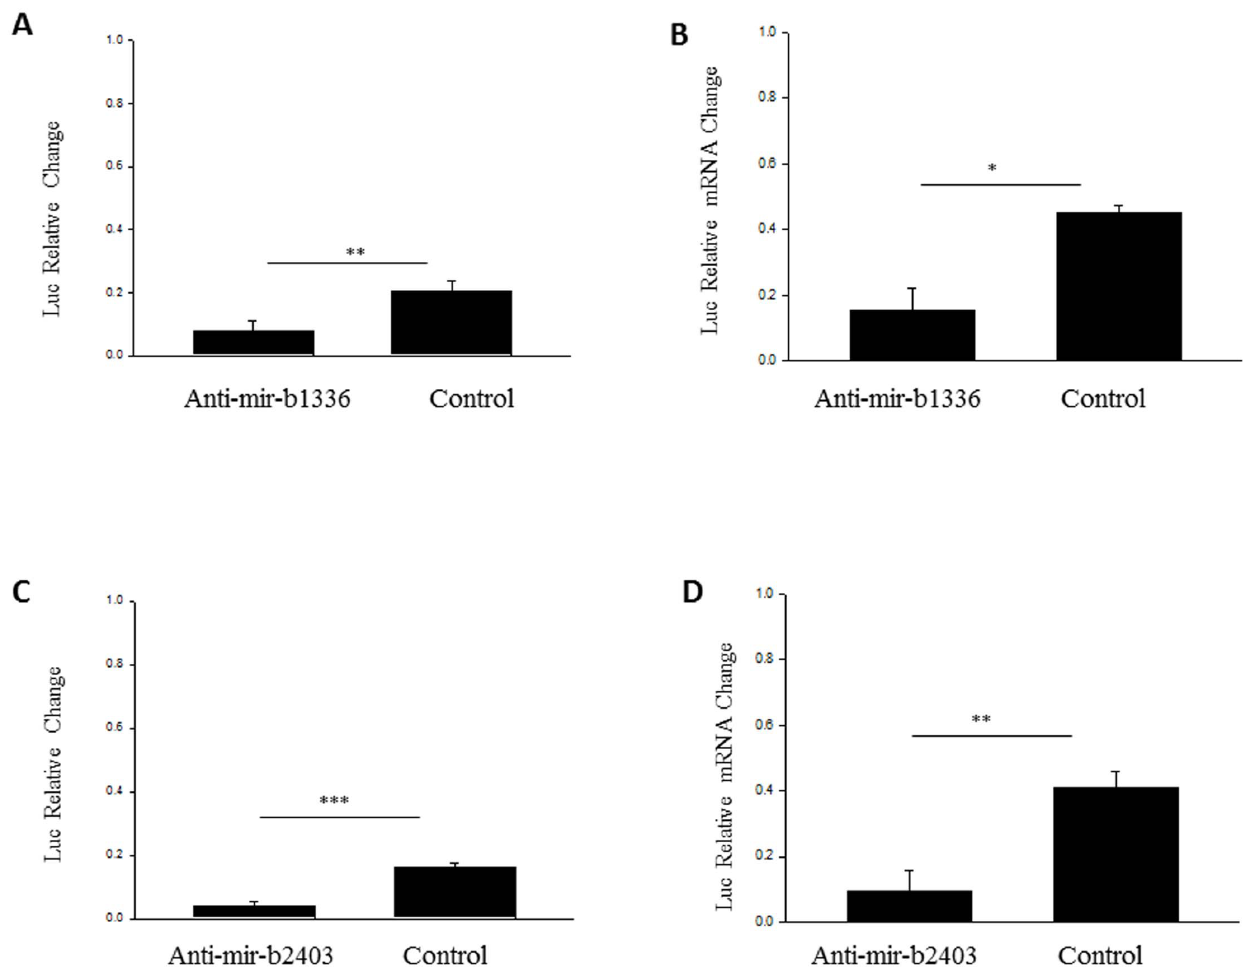
Figure 7. The inhibition of miR-b1336 and miR-b2403 using anti-miR-b136 and anti-miR-2403, respectively, resulted in the loss of the stabilizing effect. A and B represent the luciferase reporter assay and the RT-PCR analysis respectively from miR-b1336. Similarly, C and D represent luciferase reporter assay and the RT-PCR analysis for miR-b2403. Experiments were performed in triplicate and data are expressed as relative change. Results are shown as mean 6 SEM (t-test: *** =p , 0.001; **=p , 0.005; *=p ,